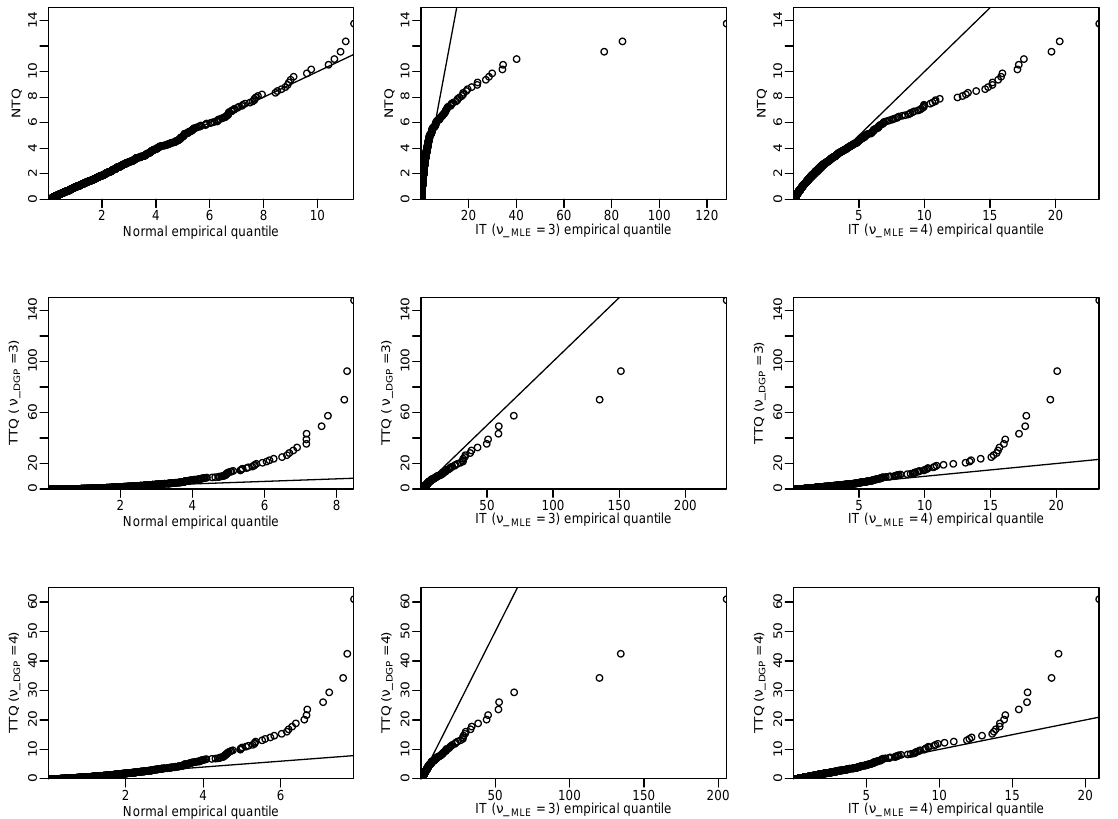
Figure 5. Toy data: Q-Q plots of the Mahalanobis distances of the residuals for the normal (respectively, the IT with ν DGP = 3, the IT with ν DGP = 4) case empirical quantiles against the normal (respectively, the IT with ν MLE = 3, the IT with ν MLE = 4) case theoretical quantiles in the first row (respectively, the second row, the third